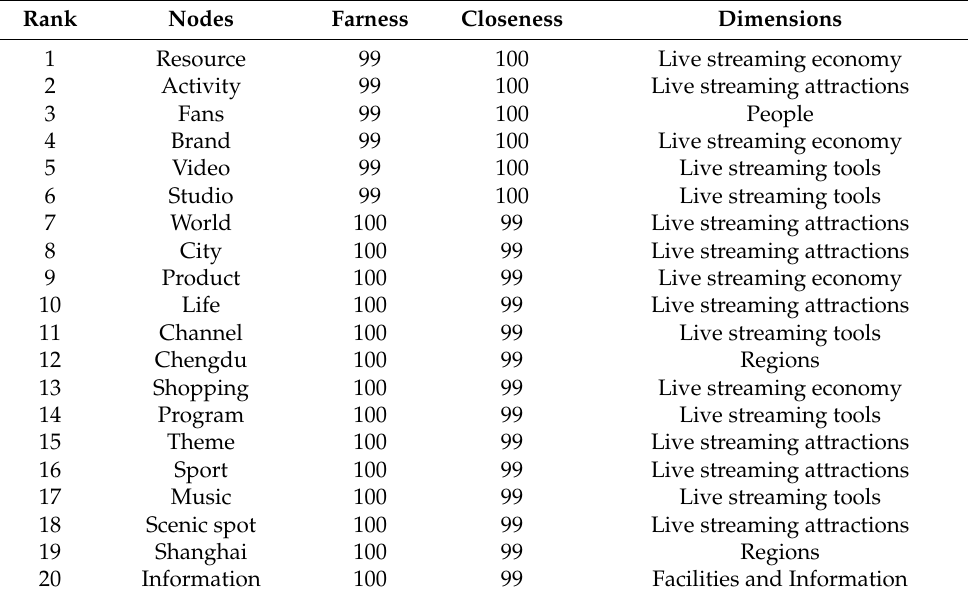
Table 3. Closeness centrality analysis of tourism live streaming.